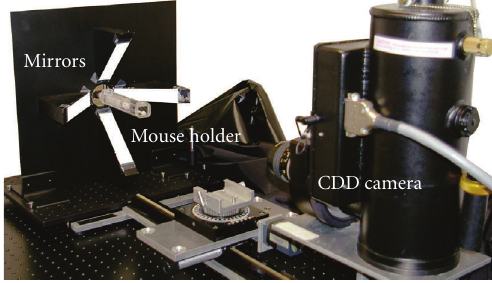
Figure 5: Prototype of a multiview system consisting of a multiview mirror system, a mouse holder, and a CCD camera. For illustration purpose, the four mirrors are colored in white.